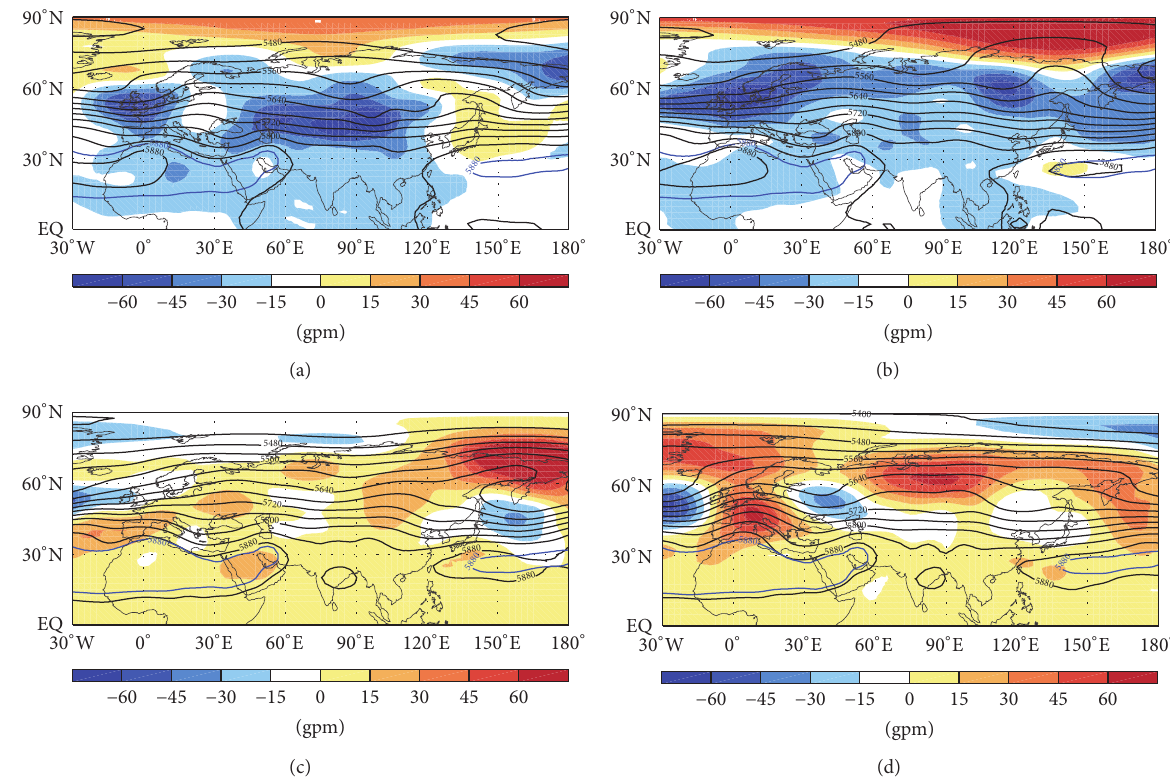
Figure 10: 500 hPa GPH (contour) and its corresponding anomalies (shading) (units: gpm) of the SDNF pattern in the summers of (a) 1963, (b) 1965, (c) 1991, and (d) 2003; blue lines denote the climatology of 5880